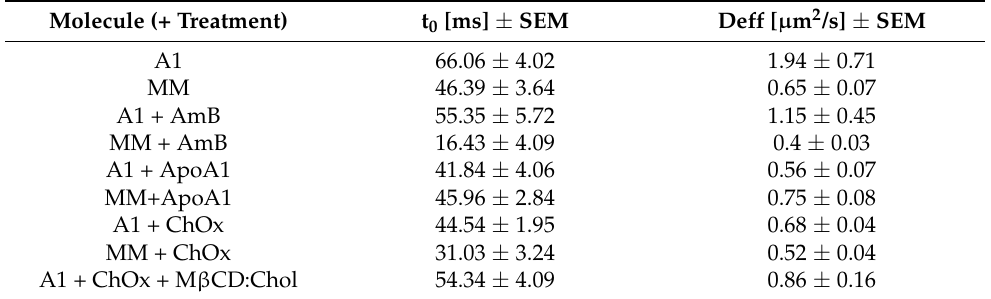
Table 1. Summary of the diffusion parameters—t 0 and D eff for ABCA1 (A1) and ABCA1MM (MM). Molecule (+